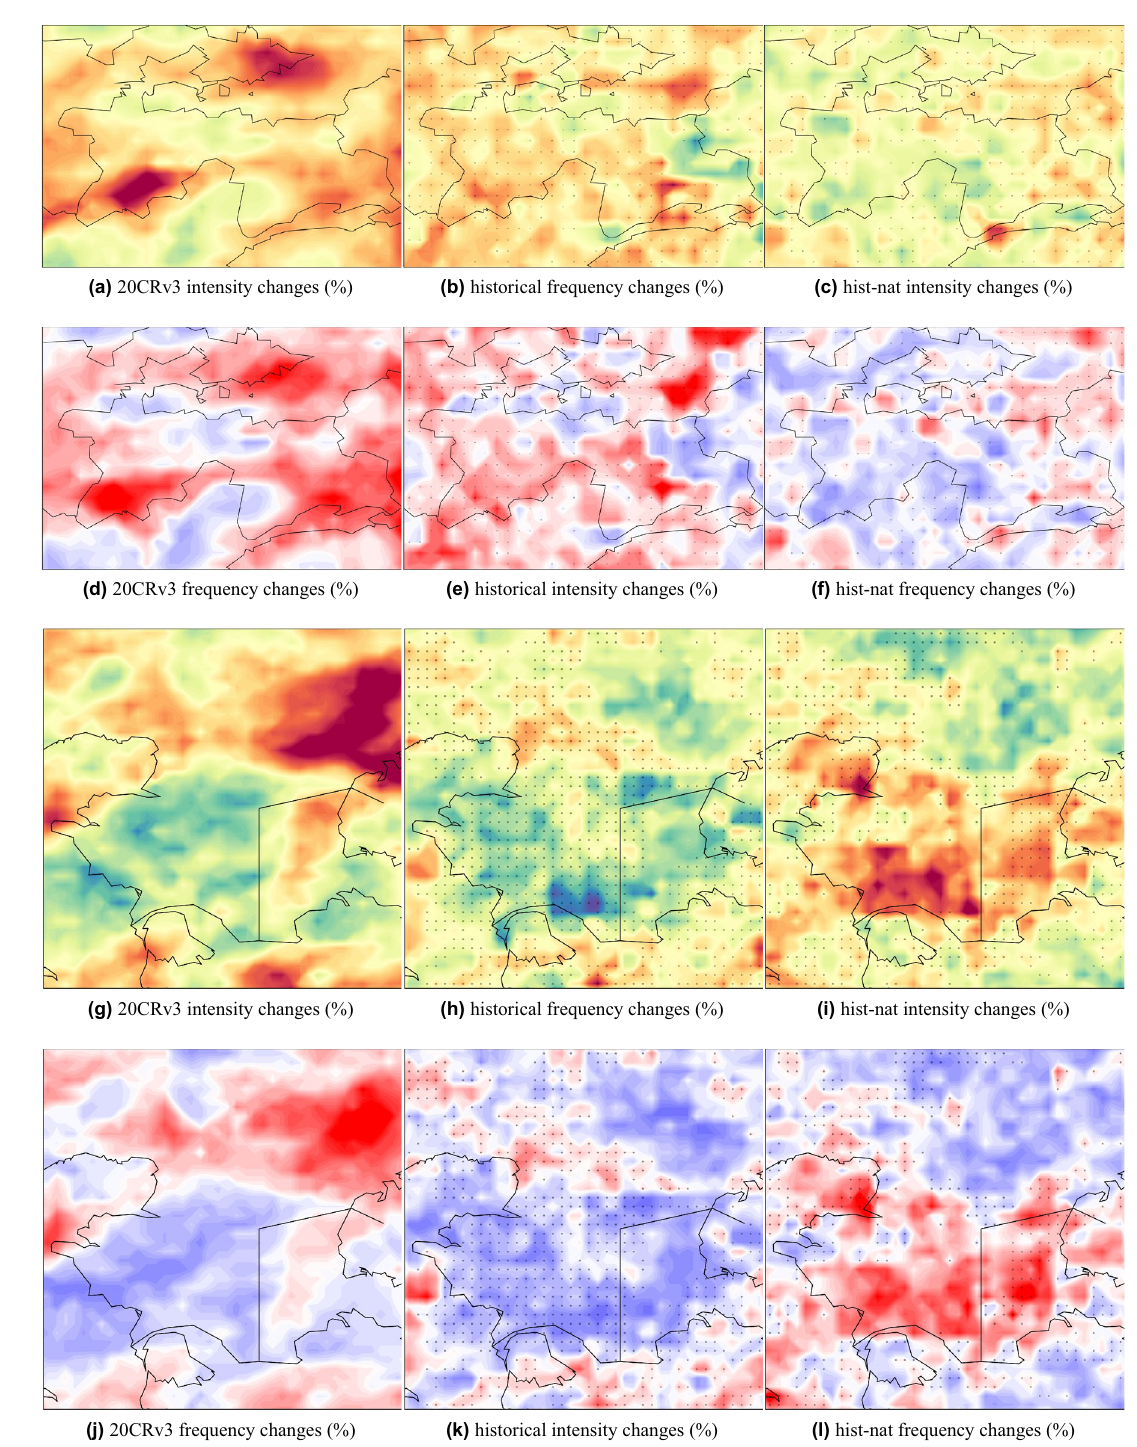
Figure 10. As in Fig. 9 but the zoom of all maps over Tajikistan is shown in ( a )–( f ) and over Mangystau Region in Southwest Kazakhstan ( g )–( l ). The maps were created using python3-matplotlib (version 3.1.2, https:// matpl otlib.